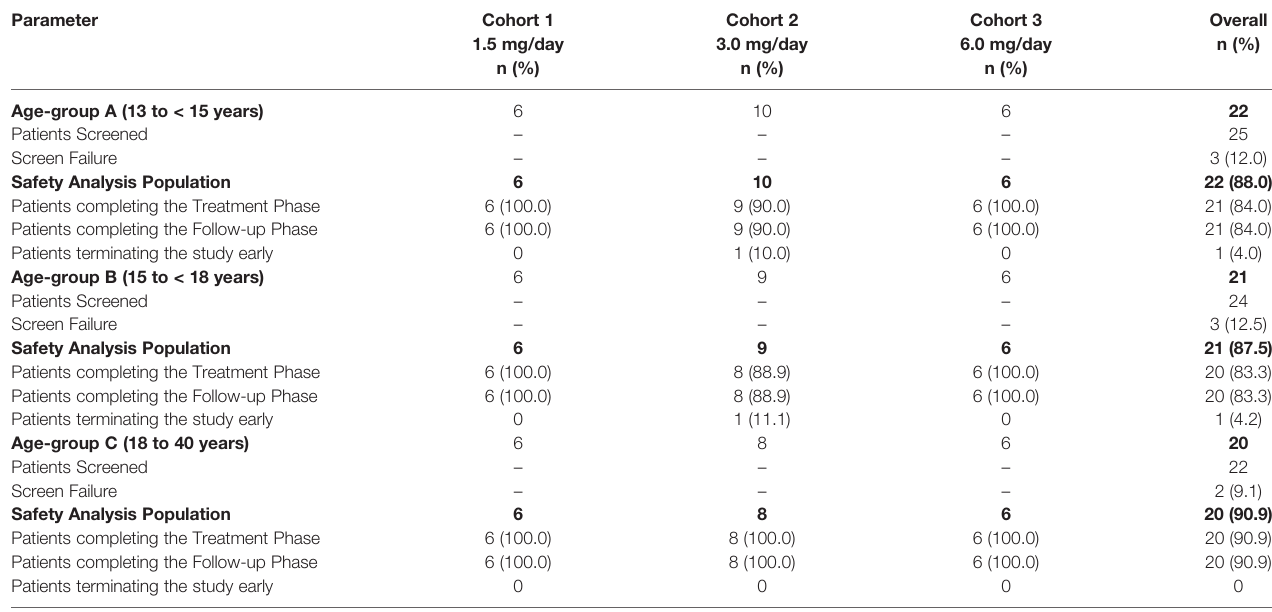
TABLE 1 | Patient disposition, Safety Analysis Population (All Screened Patients).